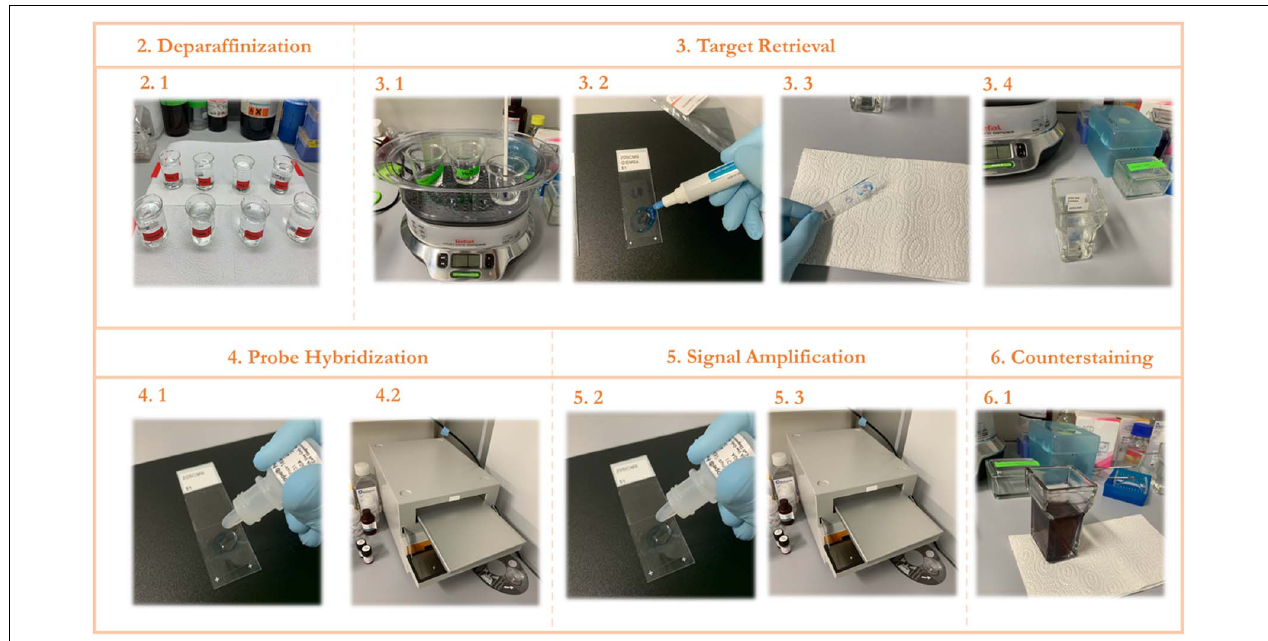
FIGURE 2 | STEP-BY-STEP Visual protocol scheme. (1) Visual summary of the RNAScope staining protocol and the different steps involved. (2) Deparaffinization of slides with subsequent washes in xylene and ethanol. (3) Permeabilization of the slide and incubation with a target retrieval solution and subsequent hydrophobic barrier and washing. (4) Probe hybridization with target RNA. (5) Signal amplification with subsequent staining with FastRed dye. (6) Counterstaining of the lung tissue with